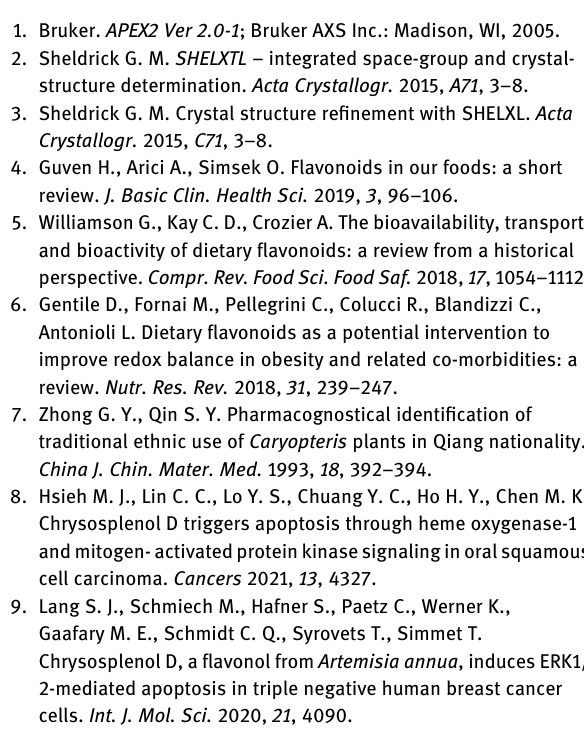
There is one molecule in the asymmetric unit (see the figure). The bond lengths and angles are all in the expected ranges [11, 12]. Detailed analysis of its crystal structure revealed that the methoxyl groups located at C-3 and C-6 are turned out from the plane of chromone skeleton, which is in accordance with that of casticin, the methyl etheri fi ed derivative at 4 ′ -OH of the title compound [11, 13]. The phenyl group at C-2 position deviated from the plane of chromone skeleton with a dihedral angle of 36.7 ° , which was unfavorable for the conjugation in cinnamoyl unit associated with characteristic UV absorption band. Thus, the conformation of phenyl group in combination with methyl etheri fi cation of 3-OH may contribute to the blue shift of band I in UV spectrum when compared with that of 3,5,3 ′ ,4 ′ -tetrahydroxy-6,7-dimethoxy fl avone